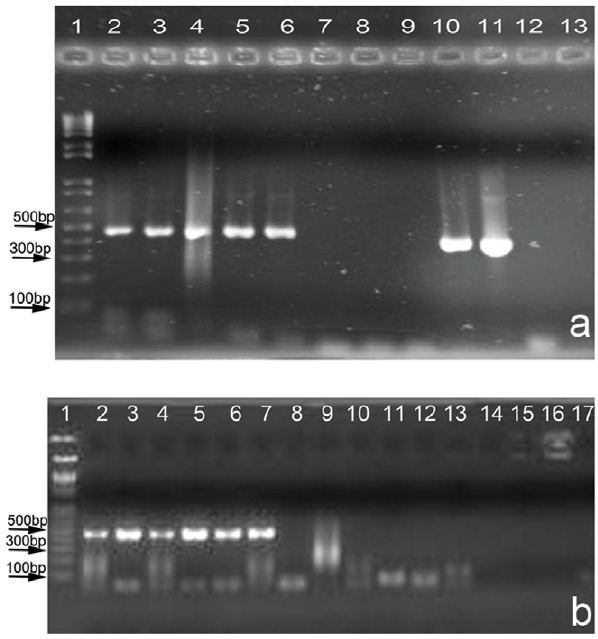
Figure 2. Agarose gel electrophoresis, Human HV1 PCR, Product size , 440 bp. a) Evaluation of different surface sterilization protocols. Lane 1: DNA ladder, 2: Ac, 3:Al, 4:Bl, 5:AlBl, 6:AlAc, 7:AcBl, 8:AlAcBl, 9,12:Extract control, 10:Alcohol, 11:Spike, 13: PCR -ve. b) Effectiveness of surface sterilization. Halite crystals (modern Saline Valley) spiked with different amounts of human DNA. Lane 1: DNA ladder, Lanes 2,3,10,11: 1.5 ng spike, Lanes 4,5,12,13: 3.0 ng spike, Lanes 6,7,14,15: 4.5 ng spike, Lanes 8,9,16,17: no spike. Lanes 2–9: no surface sterilization. Lanes 10–17 surface sterilized.